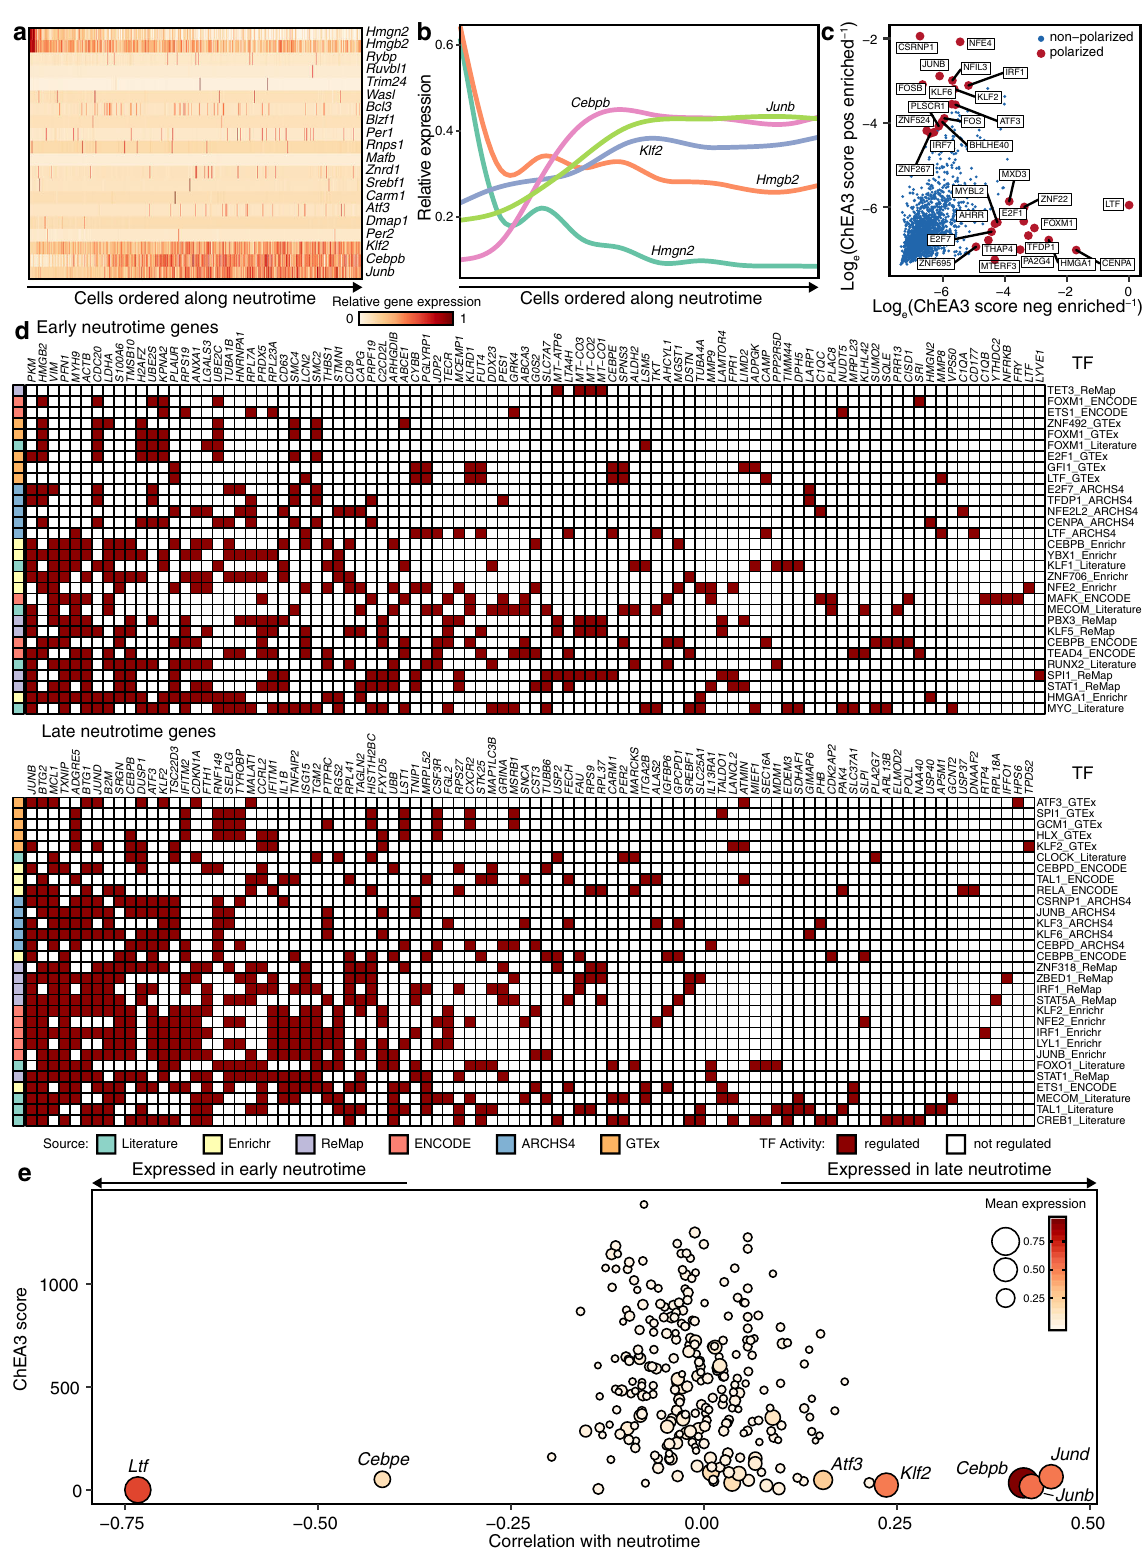
Fig. 6 Transcriptional regulation of neutrotime. a , b Expression pro fi les of highly abundant transcription factors along neutrotime. c Inferred transcriptional regulators of early and late neutrotime via ChEA3. d Transcriptional orchestration of early and late neutrotime. e Inferred regulatory activity versus transcription factor expression along neutrotime. Cells are ordered along neutrotime in a and b with the same x axis scale as in Fig. 2g. As ChEA3 contains libraries from multiple species, only the corresponding human protein symbols are shown in c and d